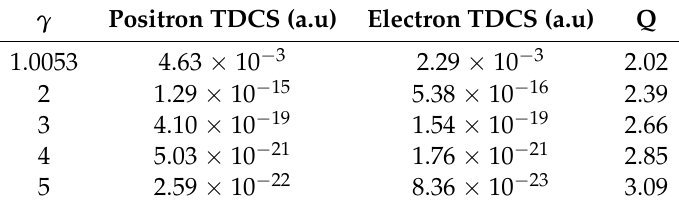
Table 2. The maximum values of TDCS for electron and positron impact and values of the positron-to-electron peak ratio for specific values of incident